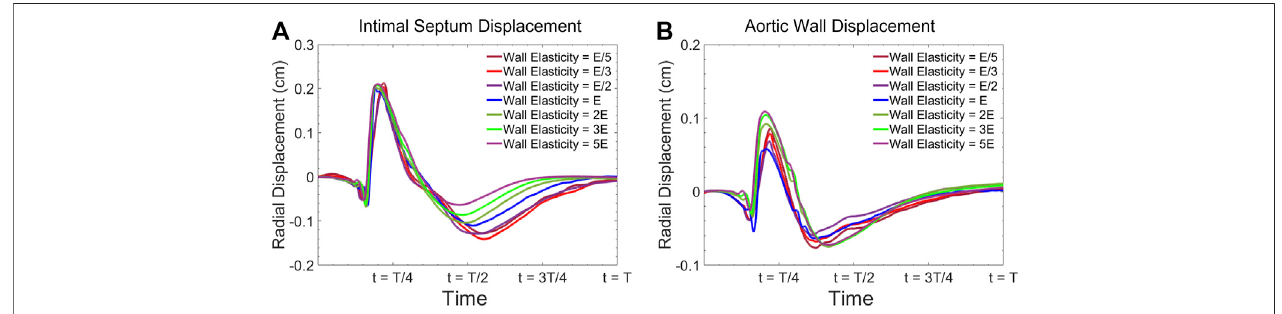
FIGURE 2 | Radial vessel wall displacement waveform at the center of the model for (A) intimal septum, and (B) the aortic wall for various